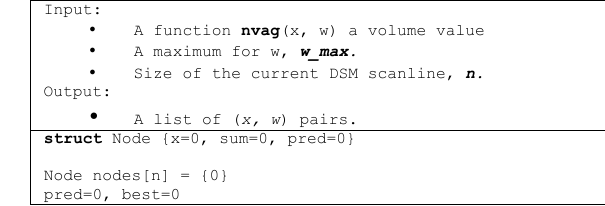
Figure 3. The &FGH area function. The cross-sectional area is defined as the dark blue area minus the red area .